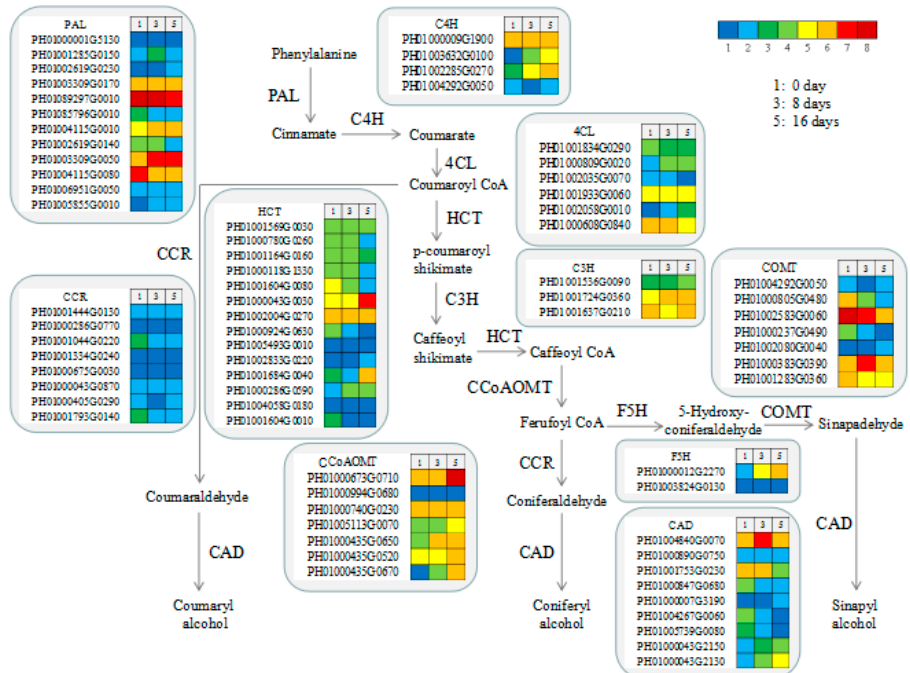
Figure 7. Genes involved in lignin biosynthesis in different periods of cold storage of MBSes. Enzyme names, unigene IDs, and expression patterns are indicated in each step. The grids with eight different colors from blue to red show the RPKM values. Here, 0-5, 5-10, 10-20, 20-40, 40-80, 80-160, 160-320, and over 320 are represented by colors 1 to 8, respectively.